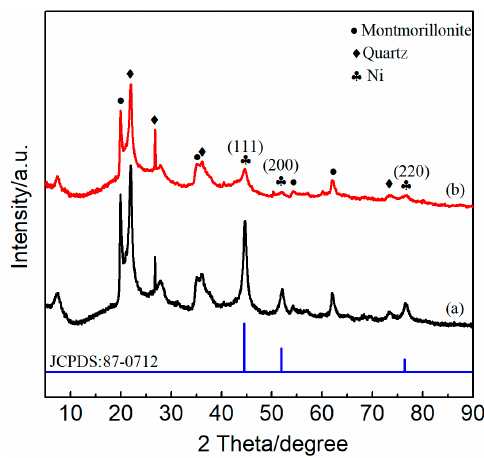
10 of 15 Figure 9. Stability performance of Ni/bentonite and Ni-2wt%Mn/bentonite catalysts. Reaction conditions: atmospheric pressure, T = 300 °C, V (H 2 )/ V (CO 2 ) = 4, GHSV = 3600 mL·g cat − 1 ·h − 1. During the 150-h reaction, the CO 2 conversion under the catalysis of Ni-2wt%Mn/bentonite catalyst remained at about 87%, and CH 4 selectivity was above 99%. For the Ni/bentonite catalysts, the CO 2 conversion decreased from 84.8% to 78.4%. The results indicated that the Ni- 2wt%Mn/bentonite catalysts exhibited a better catalytic stability than the Ni/bentonite catalysts did, and showed a higher catalytic activity at low temperatures. 2.10. Catalyst Characterization after the Reaction The diffraction peaks of montmorillonite and quartz in the two catalysts after the 150-h stability test are shown in Figure 10. The diffraction peaks of montmorillonite were found at 2 θ = 5–10°, which indicated that the layered structure of bentonite was not destroyed after the 150-h reaction. The diffraction peaks at 2 θ = 44.6°, 52.0°, and 76.6° (JCPDS card NO.87-0712) corresponded to the crystal